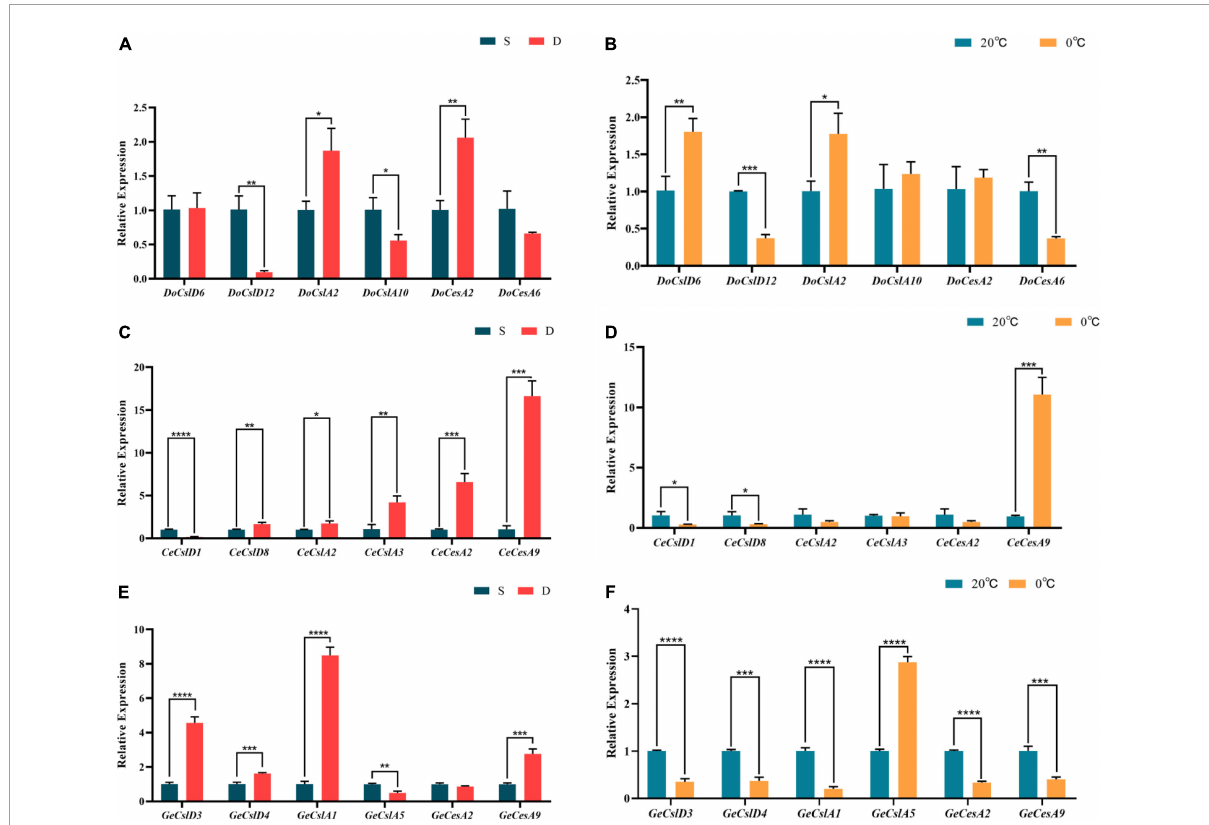
FIGURE5 Histogram of the expression changes of selected genes of D. officinale , C. ensifolium, and G. elata under drought and low-temperature stress validated by qRT-PCR. (A) Gene expression changes of D. officinale under drought stress (S means normal watering, D means drought stress for 20 days, same below). (B) Gene expression changes of D. officinale under freezing stress (20 ◦ C, 0 ◦ C, and same below). (C) Gene expression changes of C. ensifolium under drought stress. (D) Gene expression changes of C. ensifolium under freezing stress. (E) Gene expression changes of G. elata under drought stress. (F) Gene expression changes of G. elata under freezing stress. T -tests were performed to determine whether expression changes were significant with **** P ≤ 0.0001; *** P ≤ 0.001; ** P ≤ 0.01; * P ≤